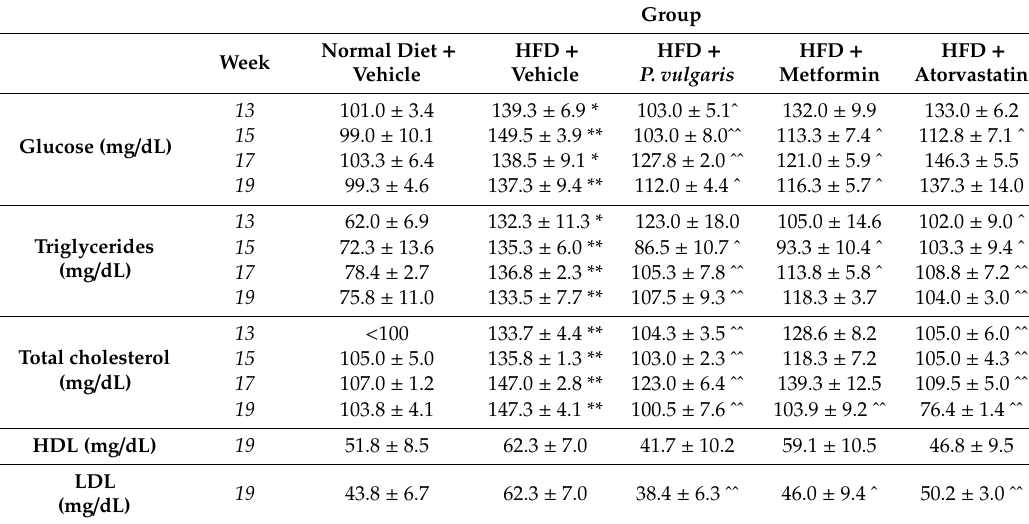
Table 1. Hematic